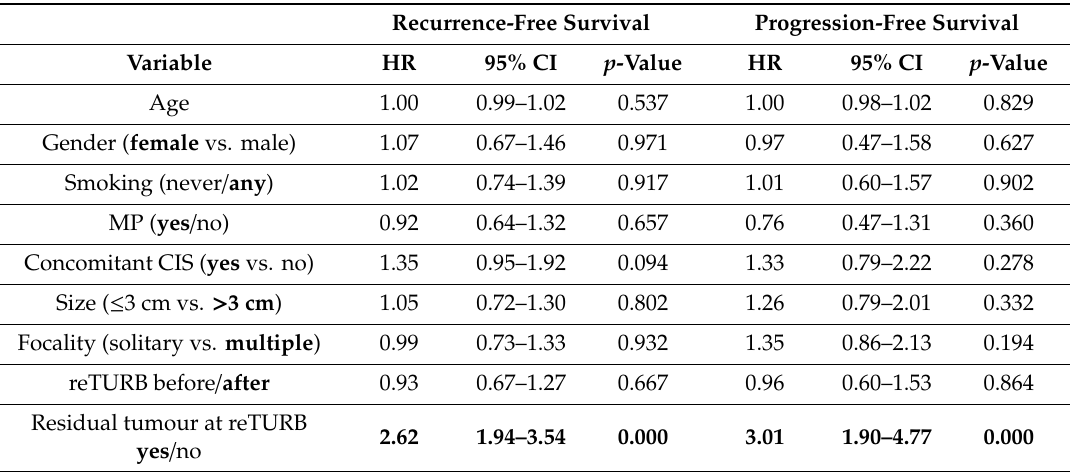
Table 2. Multivariable analysis assessing factors associated with disease recurrence and progression. Recurrence-Free Survival